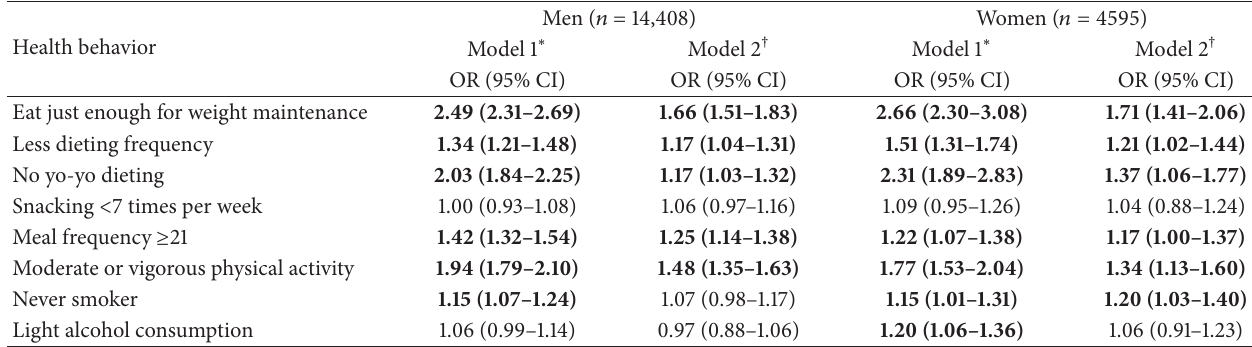
Table 7: Association of weight satisfaction with weight-related health behaviors among women ( 𝑛 = 4595 ) and men ( 𝑛 = 14, 408 ) in the Aerobics Center Longitudinal Study,